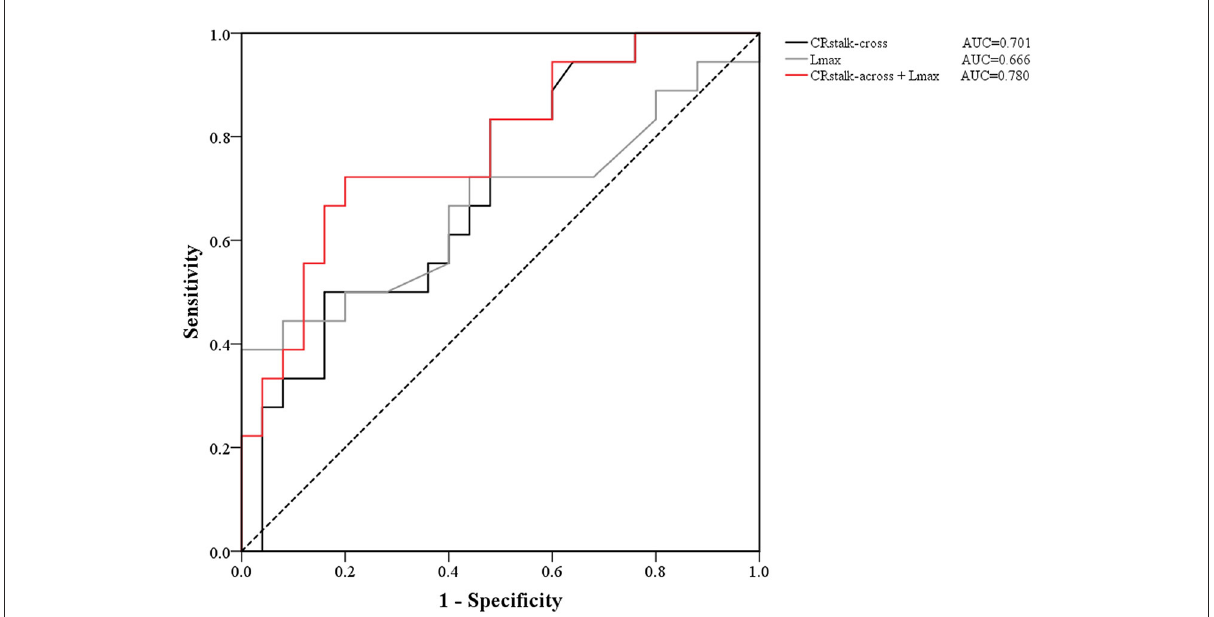
FIGURE3 ROC curves of the contrast ratio of CR stalk − cross , L max , and the joint variable (CR stalk − cross + L max ). The AUC value of CR stalk − cross , L max , and CR stalk − cross + L max were 0.701, 0.666, and 0.780, respectively. CR stalk − cross , aneurysm-to-pituitary stalk in the cross-axis section; L max , the maximal length of the long-axis